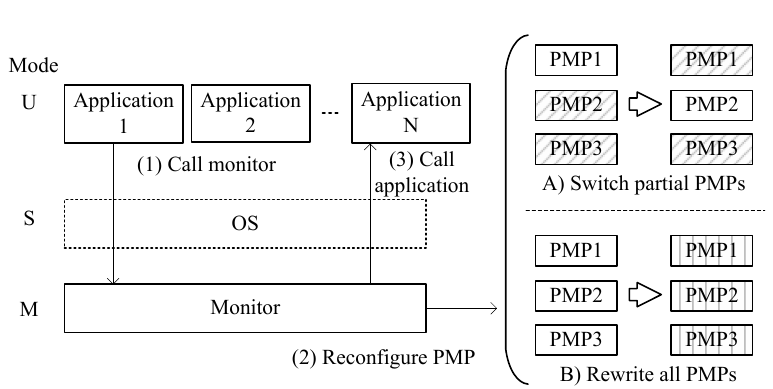
Figure 2: Context switch on TEE. A square box denoted as “PMP i ” denotes i th PMP